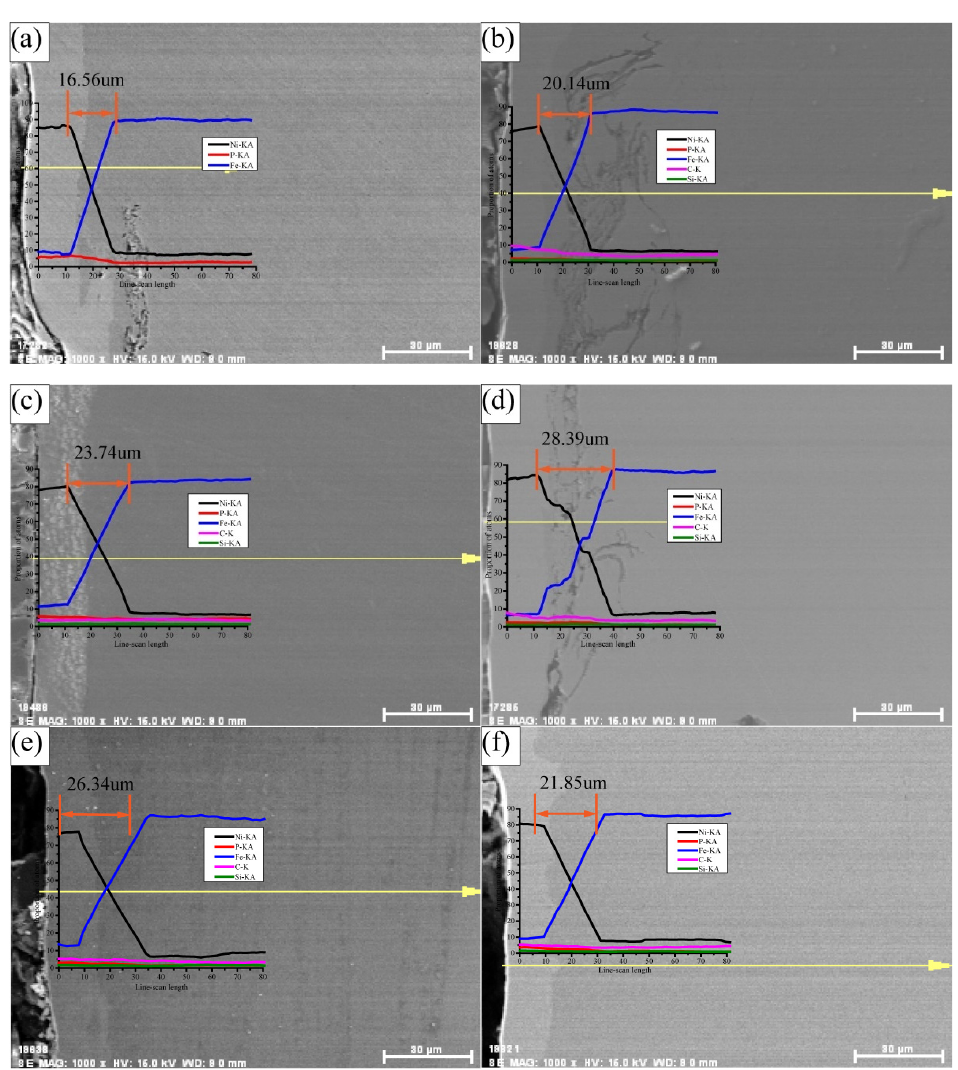
Figure 4. Coating section elemental scanning results of composite coatings with different particle concentrations (( a ) 0, ( b ) 1, ( c ) 2, ( d ) 3, ( e ) 4, and ( f ) 5 g·L − 1 ) prepared on 45 steel substrates through scanning electrodeposition.